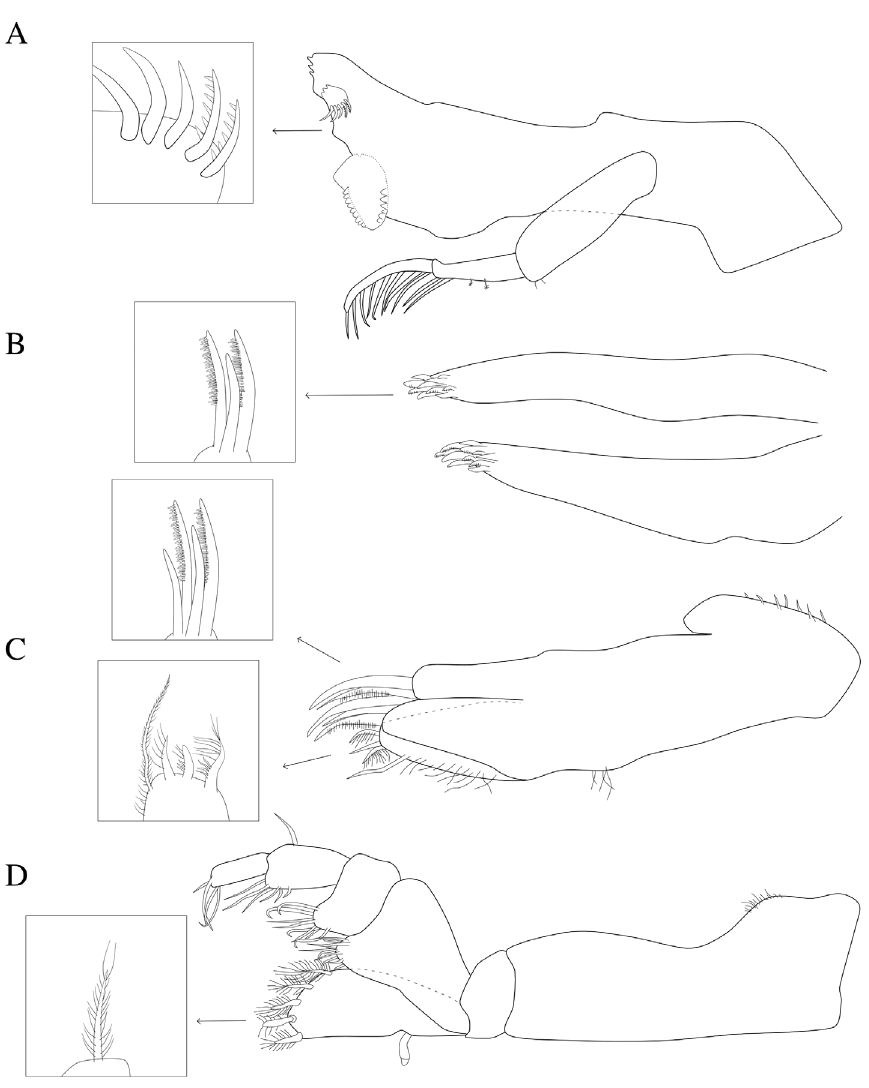
Figure 2. Dynoides elegans . ♂ Paratype. USNM 1422085. All mouthparts from left. A mandible B maxillula C maxilla D